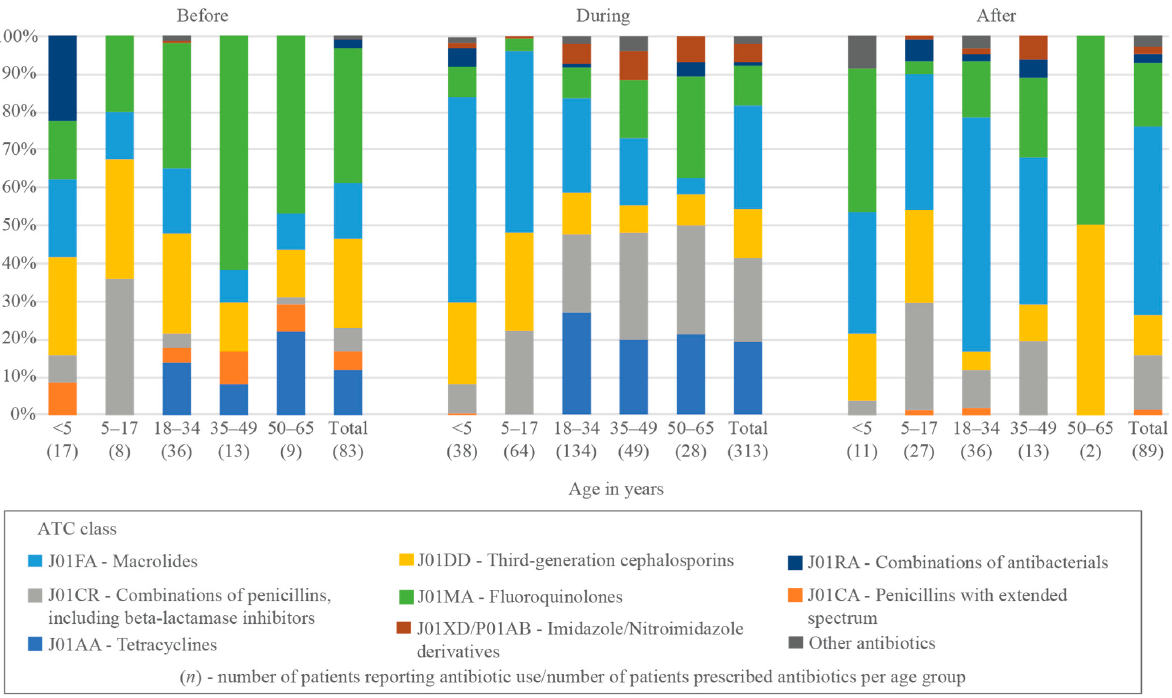
Figure 2. Distribution of antibiotic use before, during, and after outpatient visit, across age groups, according to WHO ATC classification by percentage of total Defined Daily Doses (DDDs).